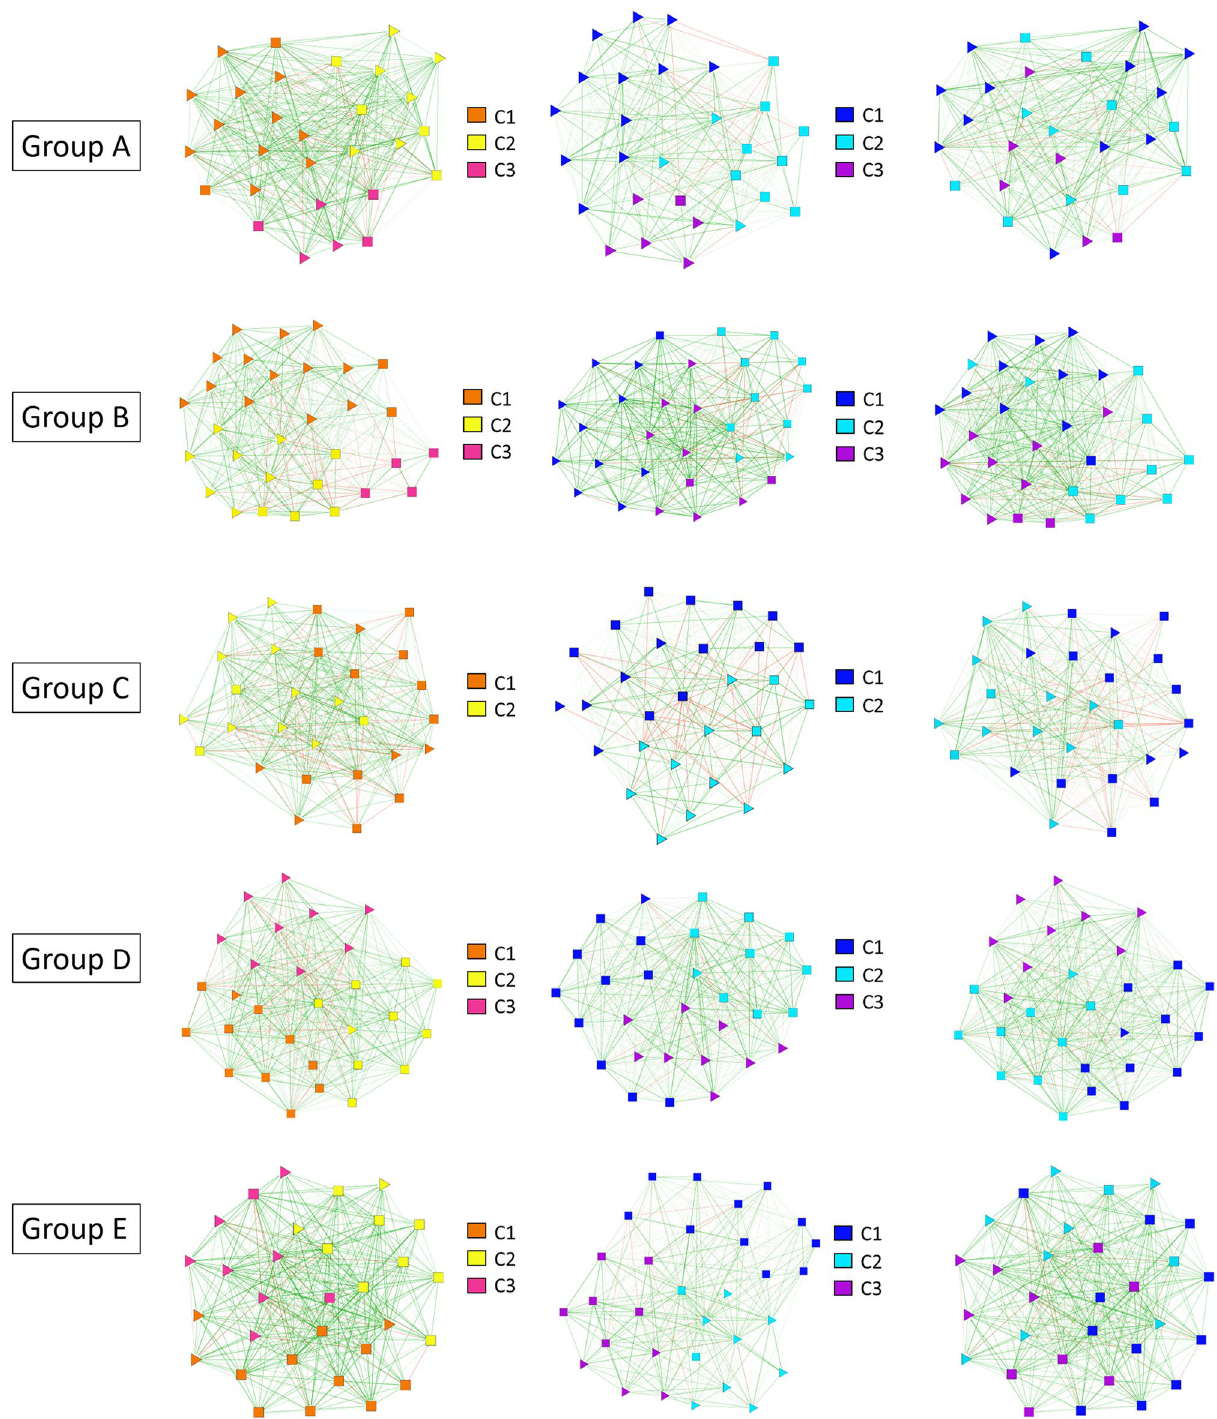
Figure 7. Network representation of all the social relations within each group in wave 1 (left) and wave 2 (center) along with the community structure of the network. The networks on the right also correspond to wave 2 (center) but, in order to facilitate comparison, nodes are laid out in the same position as in wave 1, whereas links and color codes for communities correspond to wave 2. The shape of each node represents its gender: triangles for girls and squares for